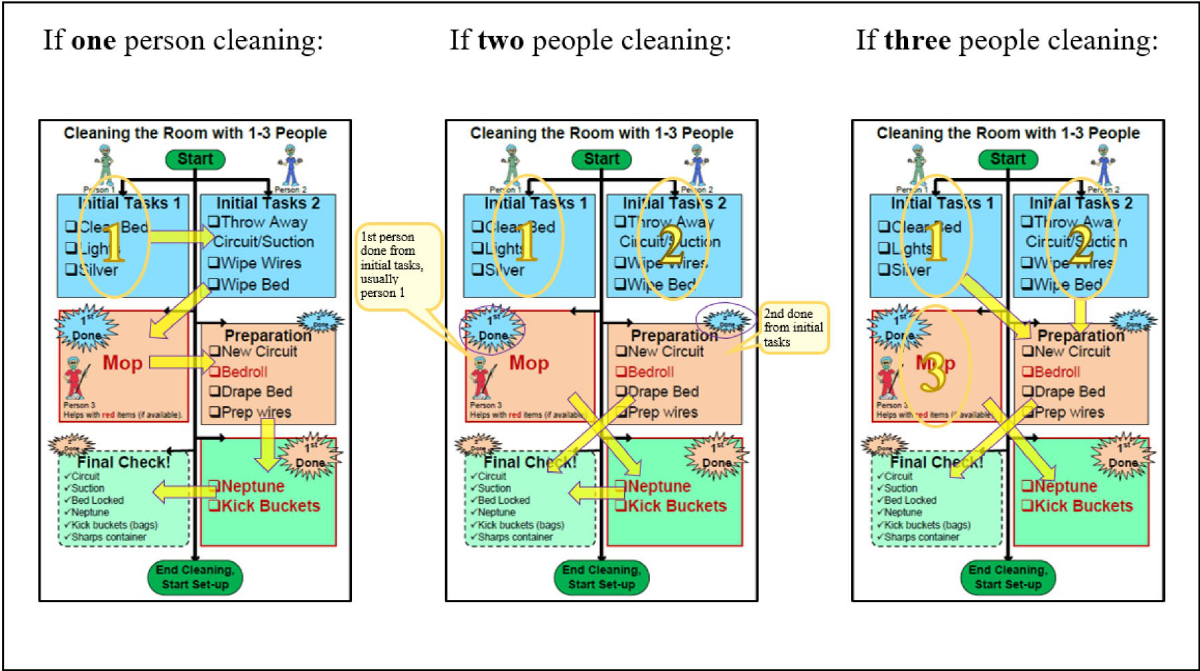
Figure 13. How the flexibility works on the in-room